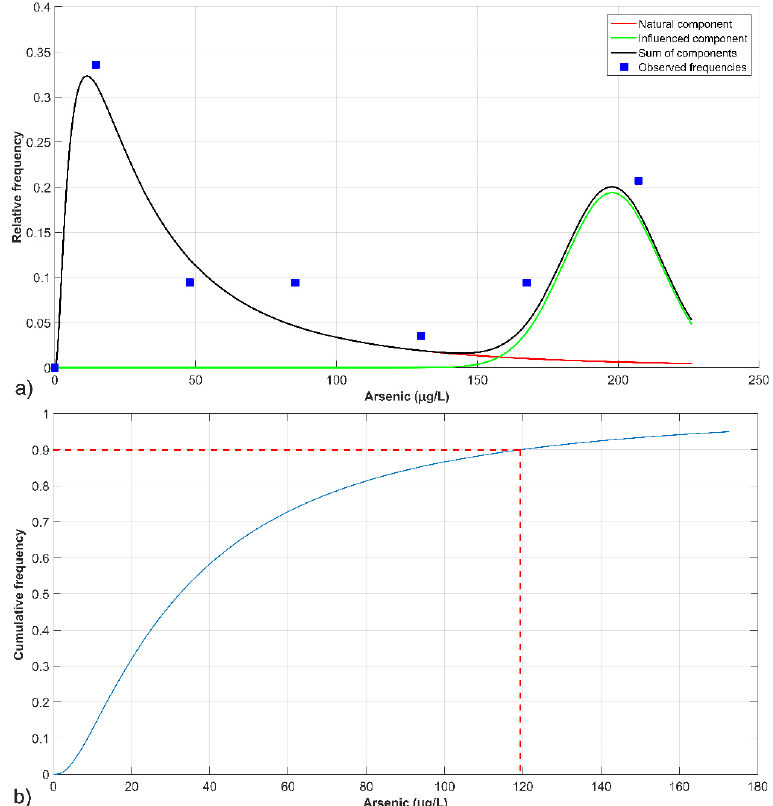
Figure 5. GuEstNBL output: ( a ) Arsenic empirical frequencies together with the estimated natural and anthropogenic components, and their weighted sum distribution; ( b ) cumulative distribution function (CDF) and 90th percentile of the identified log-normal PDF. Table 1. GuEstNBL output: Results of the guided estimation procedure for arsenic dataset.